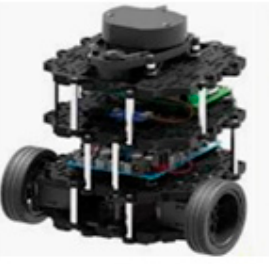
Figure 18. Turtlebot ‐ 3. Figure 18.